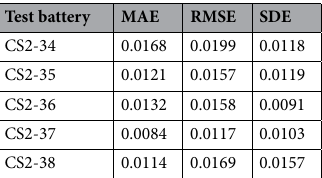
Table 3. SOH estimation results for CALCE